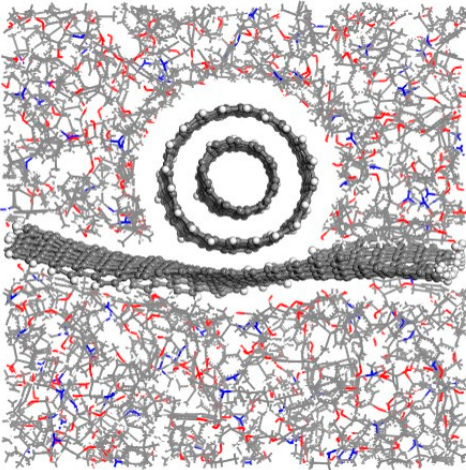
Figure 11. Equilibrium structures of composite models with a double-walled CNT.